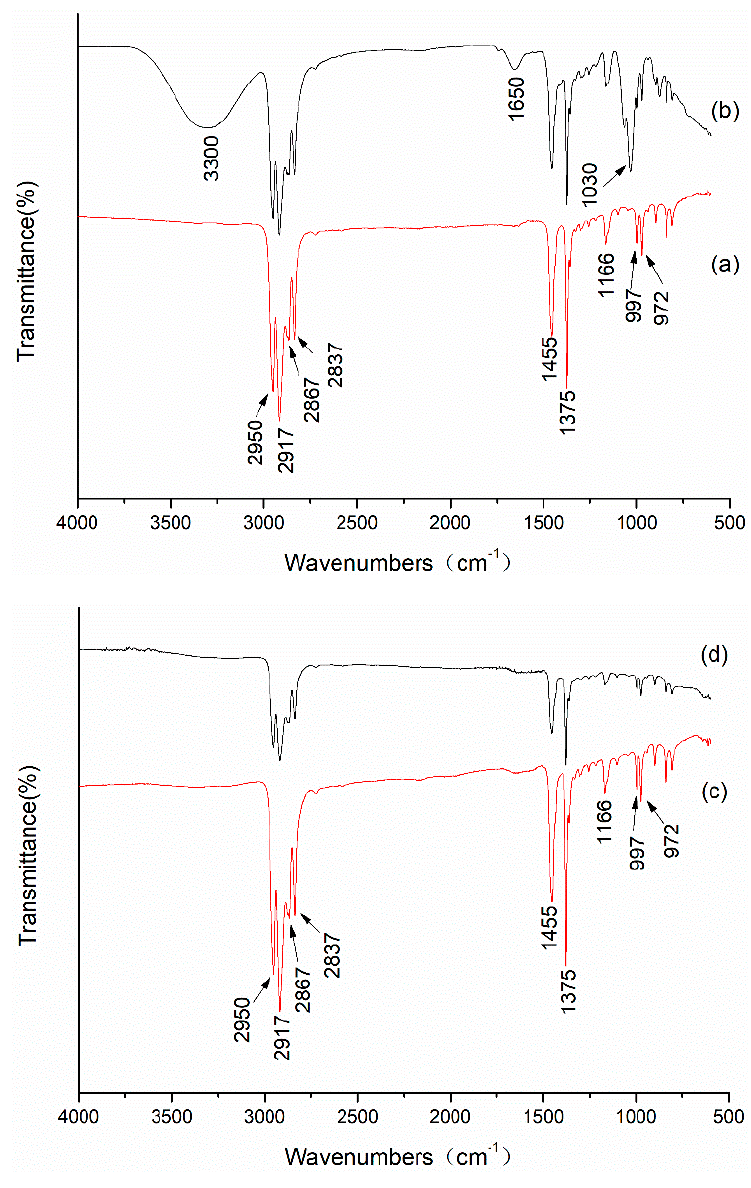
Figure 4. Fourier transform infrared spectroscopy ATR spectra of ( a ) untreated nonwoven polypropylene, ( b ) triethanolamine coated nonwoven polypropylene, ( c ) Ag coated nonwoven polypropylene (1#), and ( d ) Ag coated nonwoven polypropylene (3#).